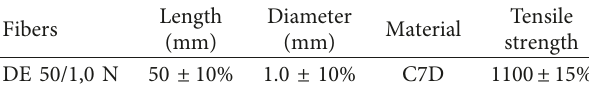
Table 2: Properties of the steel